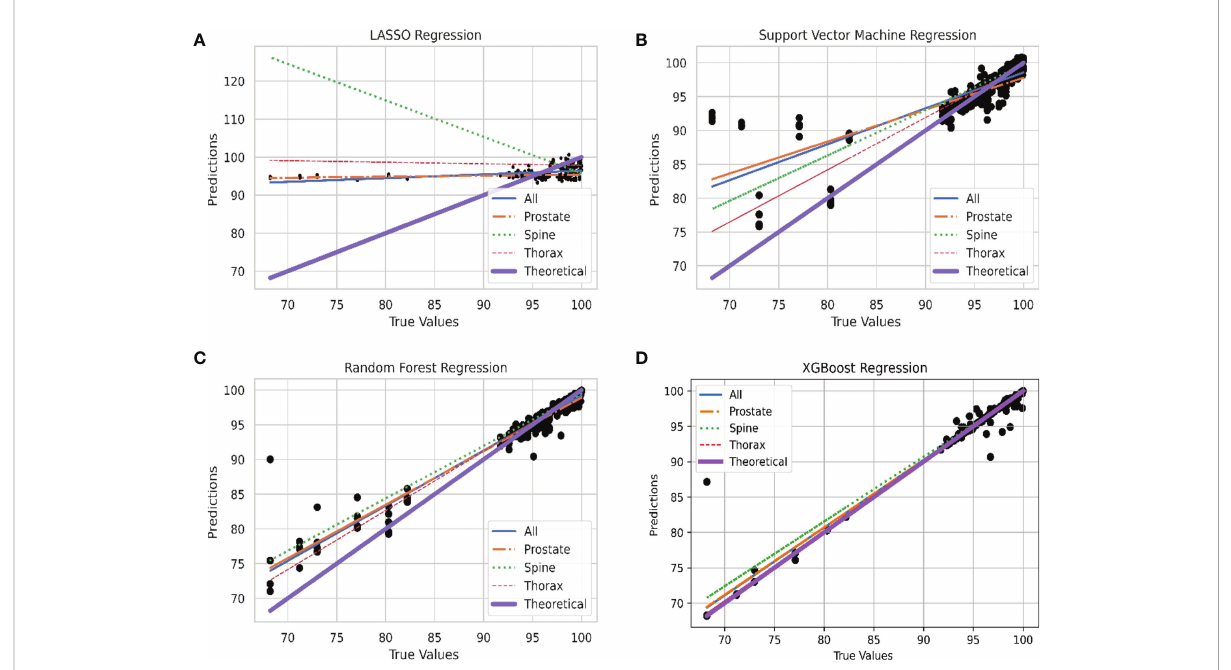
FIGURE 4 Linear Plot of Predicted and Theoretical GPR. (A) Linear plot of each site strati fi cation vs. actual GPR for LASSO Regression model. (B) Linear plot of each site strati fi cation vs. actual GPR for Support Vector Machine Regression model. (C) Linear plot of each site strati fi cation vs. actual GPR for Random Forest Regression model. (D) Linear plot of each site strati fi cation vs. actual GPR for XGBoost Regression model.